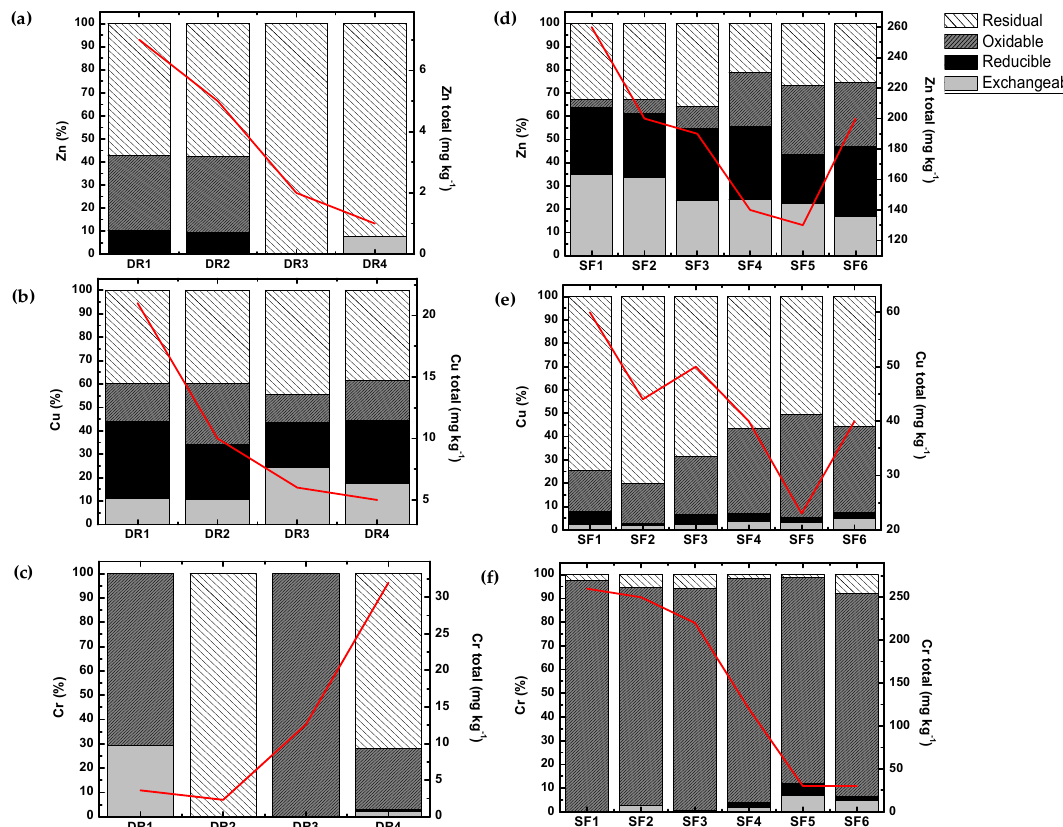
Figure 3. Percentage distribution of Zn, Cu, and Cr from each of the reservoirs investigated in the sequential extraction of the uncontaminated DR ( a – c ) and the contaminated SF, ( d – f ) sediment cores. The red line indicates the distribution of the total content of each metal with depth.